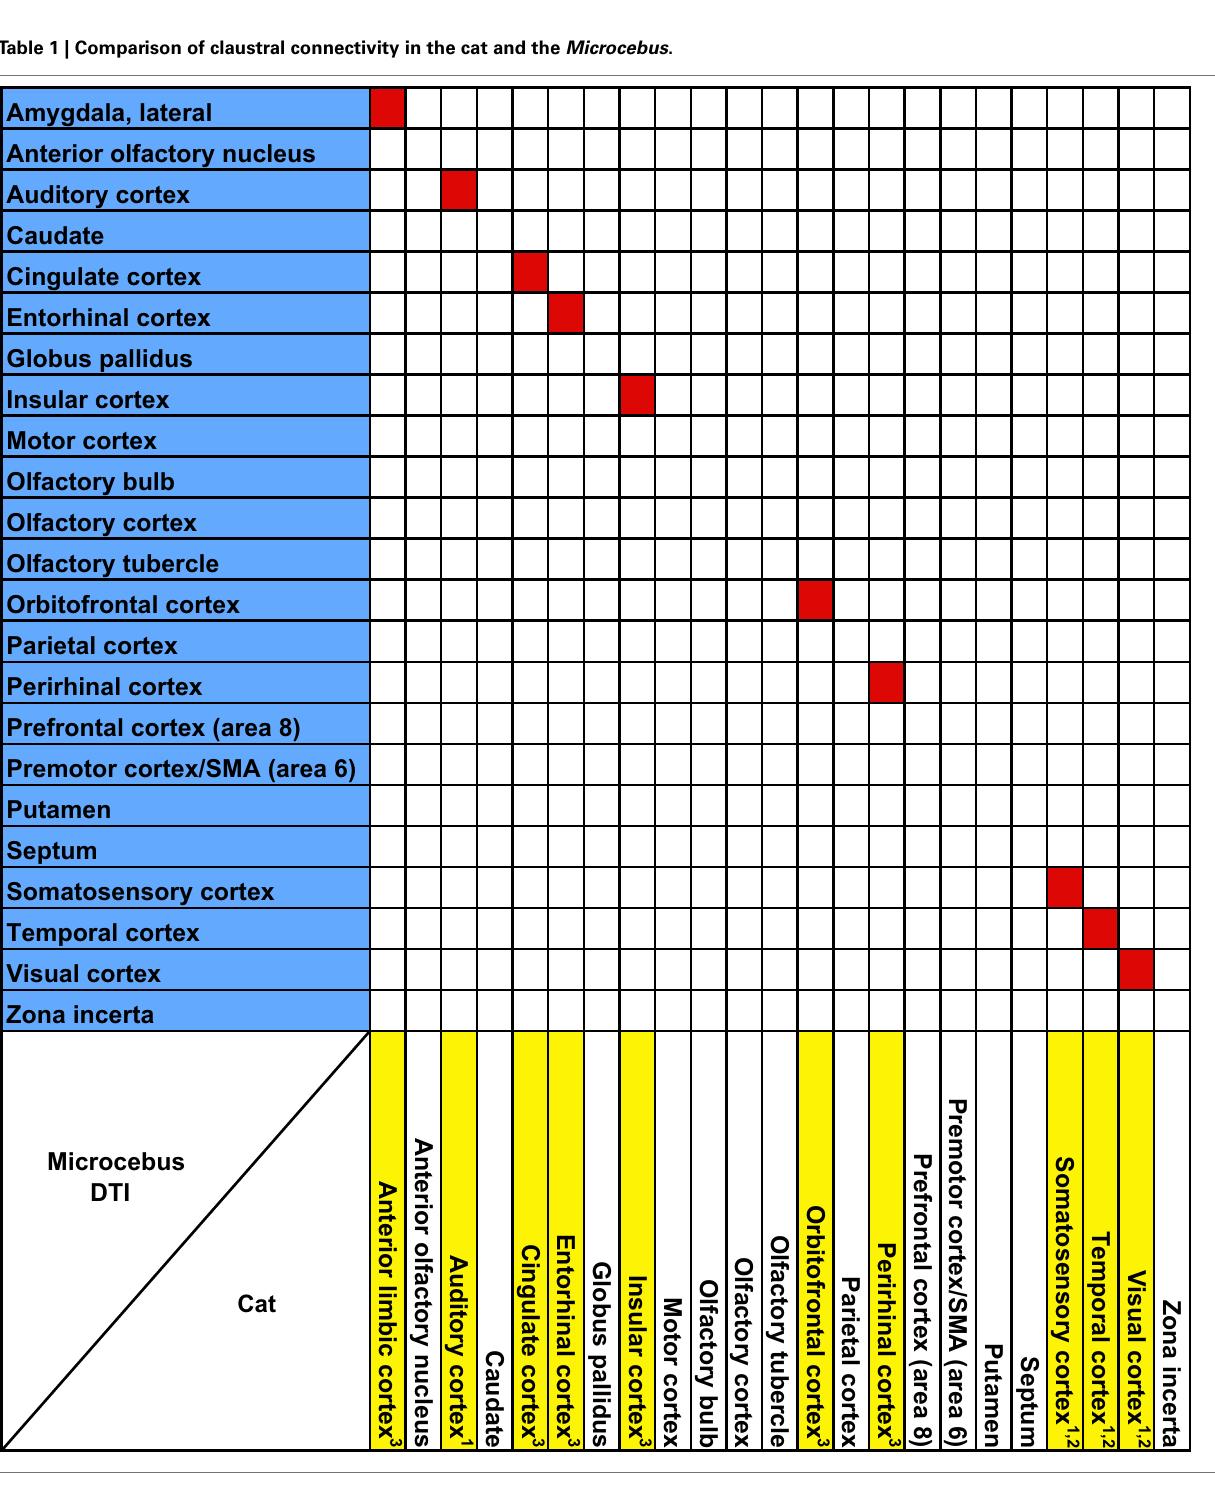
The leftmost column and the bottom row of the table both present the comprehensive list of all regions connected with the claustrum in at least one of the two species. While the column highlights in blue the regions associated with the Microcebus claustrum, the row highlights in yellow the structures shown to connect with the claustrum in cat tracer studies.The red squares mark the structures that are connected to the claustrum in both species. Studies cited: 1 Norita (1977); 2 Olson and Graybiel (1980); 3 Witter et al. (1988). Abbreviations: SMA, supplementary motor